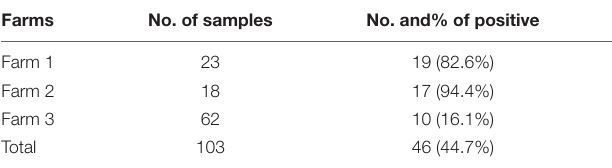
TABLE 3 | Detection rate of ORFV from the milk of dairy goats. Farms No. of samples No. and% of